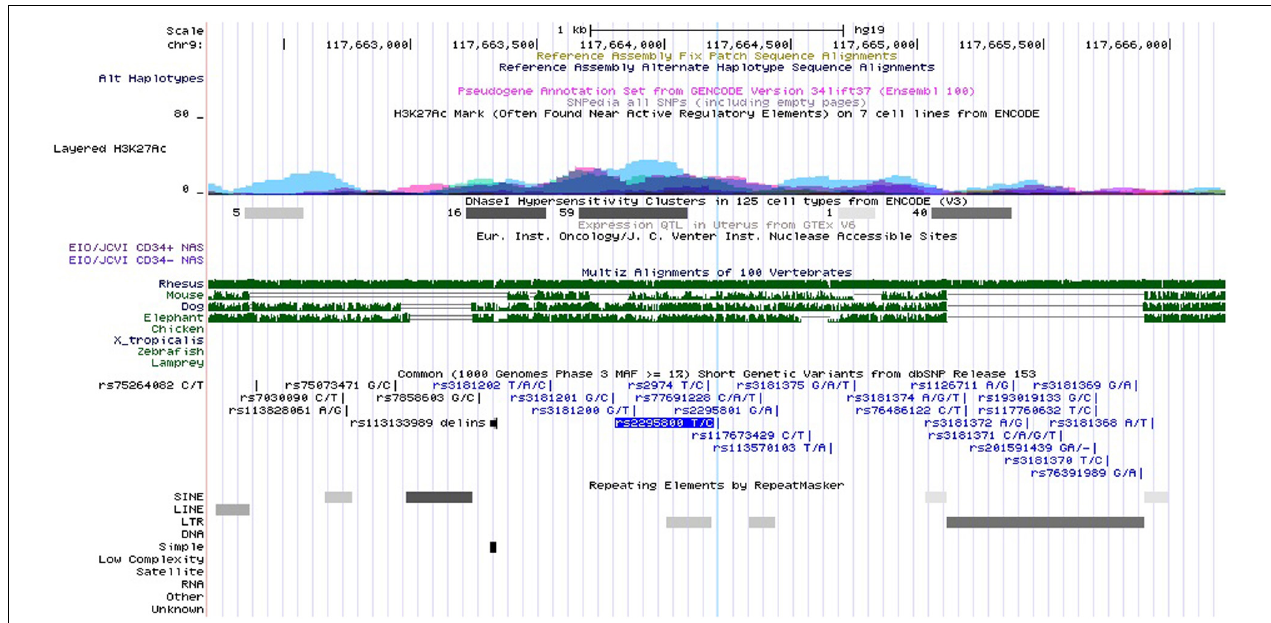
FIGURE 3 | Functional annotation for rs2295800 using ENCODE data from UCSC genome browser. Transcription Factor ChIP-seq Clusters show binding regions of transcription factors and other regulatory proteins. Based on ENCODE project and the UCSC genome browser data, rs2295800 is located on the highest peak of the histone H3 acetylated lysine 27 (H3K27Ac) histone marker and this track shows enrichment of the H3K27Ac histone mark across the genome as determined by a ChIP-seq assay. The light blue line indicates the position of SNP rs2295800 (available at